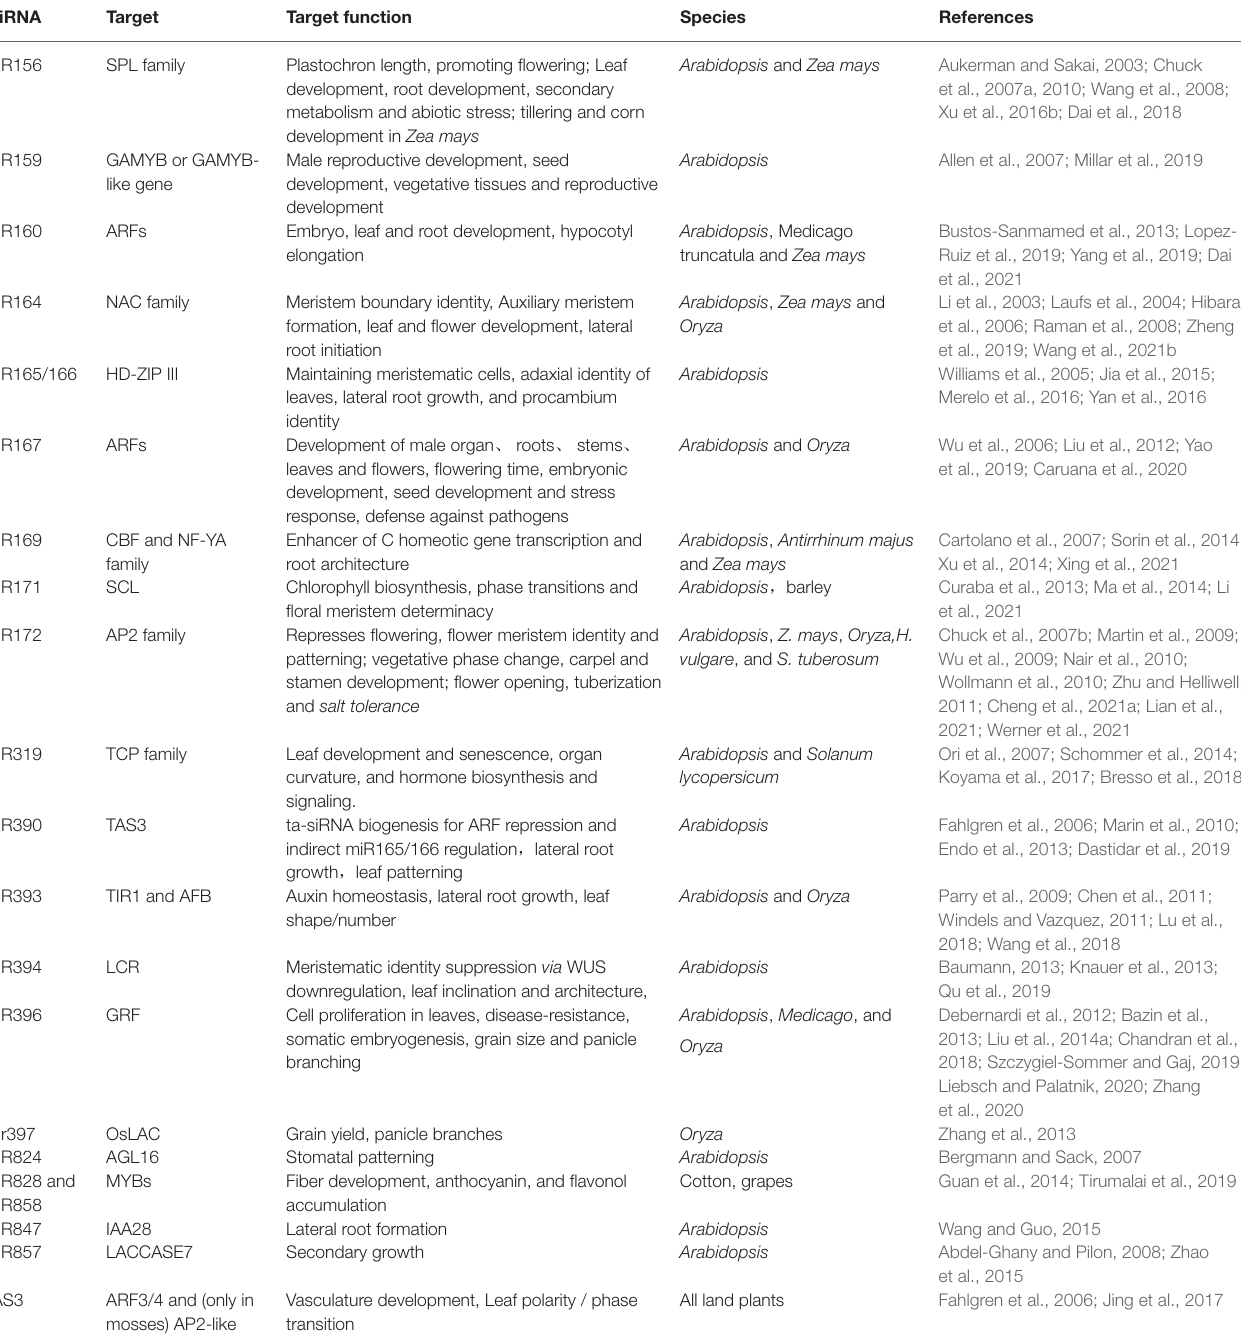
TABLE 1 | miRNAs, the targets, and their roles in plant development. miRNA Target Target function